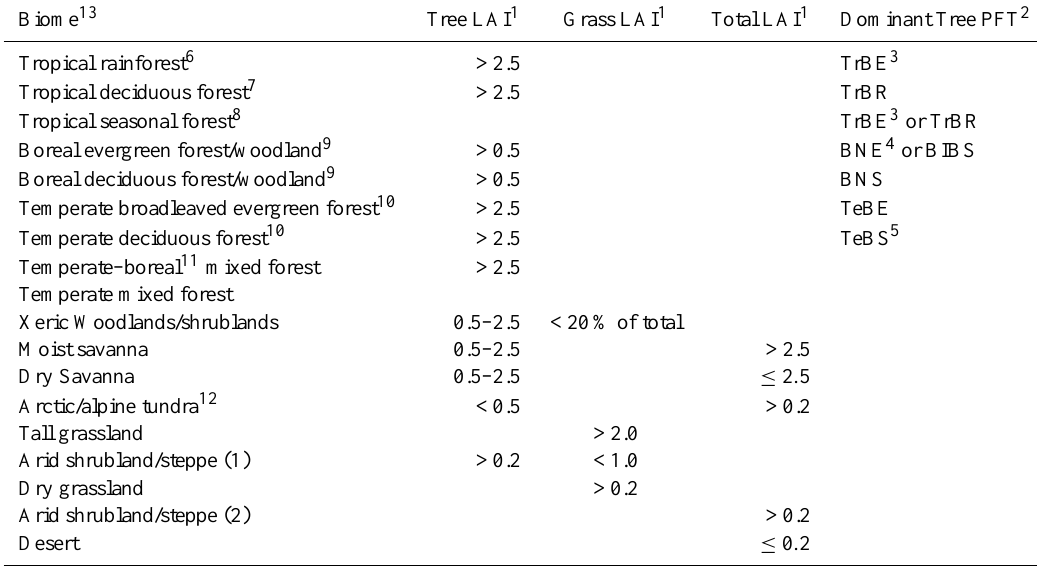
Table B1. Classification scheme for deriving vegetation biomes from PFT abundances (leaf area index, LAI), following Smith et al. (2014). Biome 13